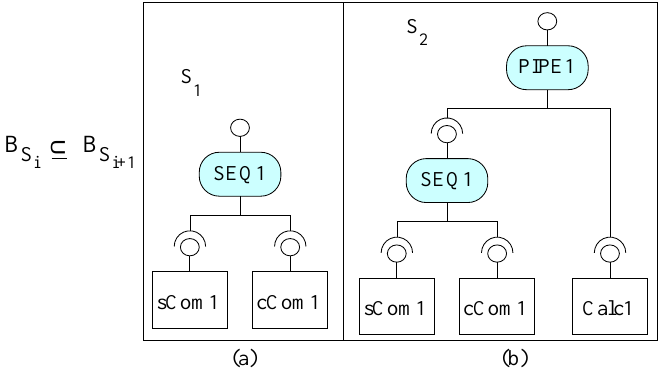
Figure 23. EX-MAN: ( a ) First system, and ( b ) Second